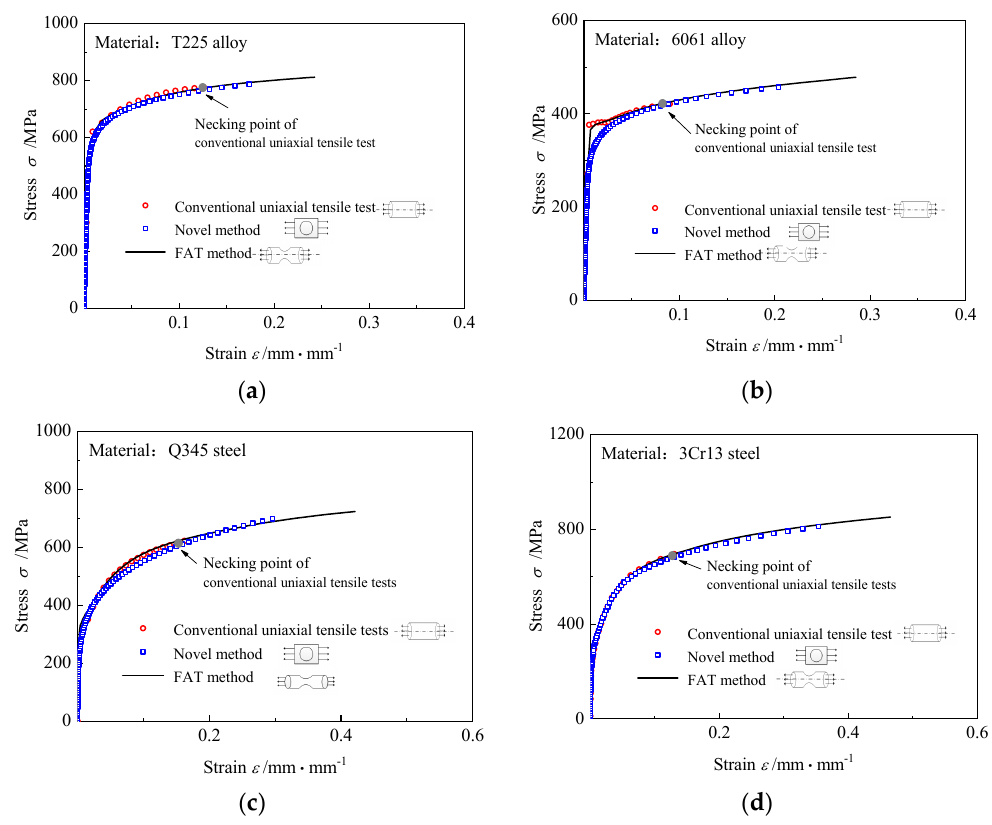
Figure 11. Comparison of the stress-strain curves obtained using three types of methods, ( a ) T225 titanium alloy; ( b ) 6061 aluminum alloy; ( c ) Q345 steel; ( d ) 3Cr13 steel.